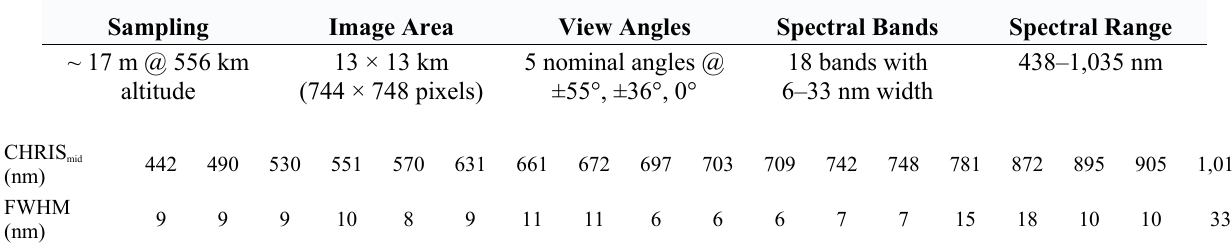
Table 1. CHRIS specifications for Land Mode 3; general information and centre wavelength (CHRIS ) and full-width-half-maximum (FWHM). mid